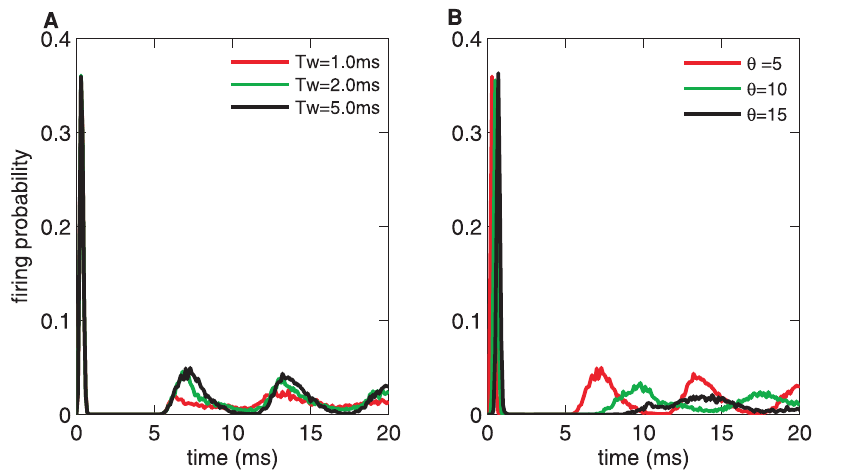
Figure 4. Influences of the refractory period on the PSTH of the CD neuron. The spontaneous firing rate exhibits a highly oscillation but it can be suppressed by the suitable intrinsic properties of the CD neuron. (A) The PSTHs of the CD neuron for h ~ 10 and T w ~ 1 : 0 , 2 : 0 and 5 : 0 ms. The first peak width of the PSTH becomes narrower and narrower with decreasing T w , and the fluctuation of the baseline disappears when T w v 0 : 5 ms. (B) The PSTHs for T w ~ 1 : 0 ms and varying h ~ 5 , 10 and 15 . With increasing h , the time delay of the first peak of the PSTH becomes longer. When h w 15 , the CD neuron depresses the oscillation. The PSTHs are obtained from 5000 trials with time steps of 0 : 01 ms averaged to 0 : 1 ms. The refractory period of the CD neuron is T rCD ~ 5 : 0 ms. The other parameters are, N ~ 100 , D t s ~ 1 ms, S 0 ~ 20 mV/ms, V th ~{ 40 mV, V r ~{ 65 mV, and t m ~ 10 ms, D ~ 20 mV/ms.